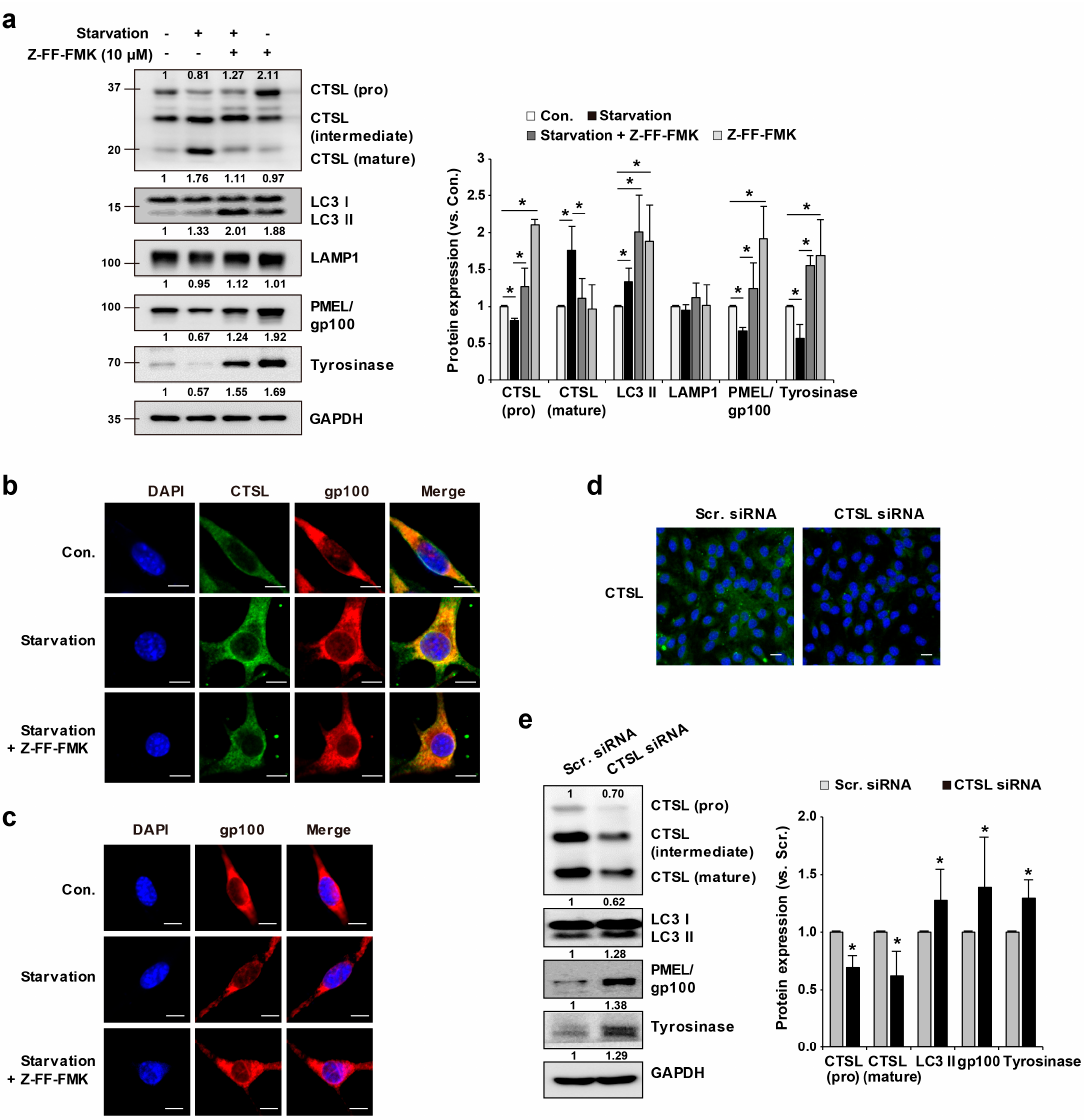
Figure 4. Inhibition of CTSL activity led to accumulation of melanosome-related molecules in melan-a cells. ( a ) After Z-FF-FMK pre-treatment and starvation for 24 h, CTSL, LC3, PMEL/gp100, and tyrosinase protein expressions were deter- mined. ( b ) CTSL and gp100 expressions were observed by confocal microscopy after Z-FF-FMK pre-treatment and star- vation for 4 h. Scale bar: 10 μ m. ( c ) gp100 expression was observed by confocal microscopy after Z-FF-FMK pre-treatment and starvation for 24 h. Scale bar: 10 μ m. ( d ) Confocal image of melan-a cells after scramble (scr) siRNA or CTSL siRNA treatment for 48 h. Scale bar: 20 μ m. ( e ) CTSL, LC3, PMEL/gp100, and tyrosinase protein expressions were evaluated after scramble (scr) siRNA or CTSL siRNA treatment for 48 h. Results are expressed as mean ± S.D of more than three inde- pendent experiments. * p < 0.05. Student’s t- test.